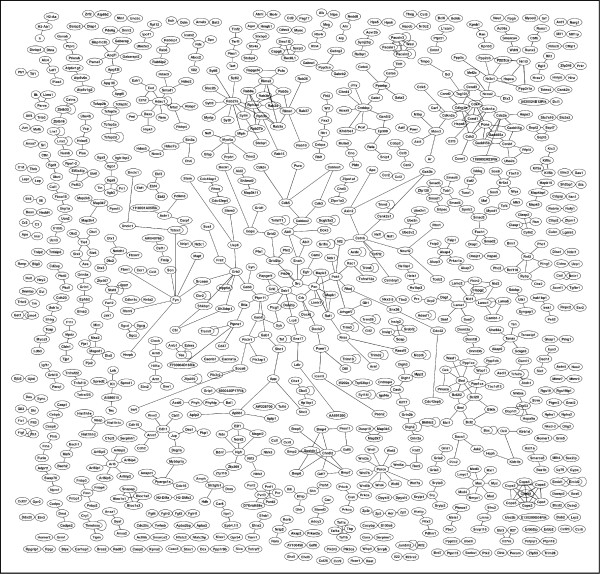
Murine protein-protein interaction catalog as documented by GO annotation to GO:0005515 protein binding.